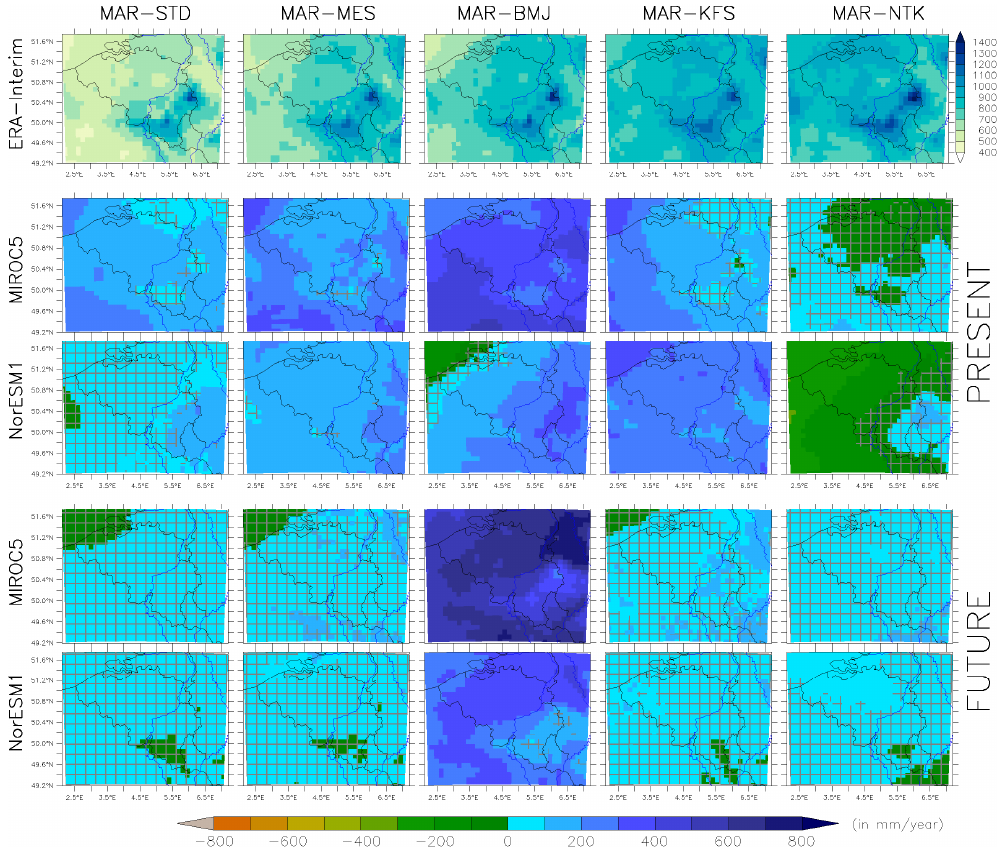
Figure 2. (Top) ERA-Interim: Mean annual precipitation (in mm/year) over 1987–2017 simulated by Modèle Atmosphérique Régional (MAR) forced by ERA-Interim for the five convective schemes. (Middle) PRESENT: Anomalies (in mm/year) between the mean annual precipitation over 1987–2017 simulated by MAR forced by MIROC5 and NorESM1-M compared to MAR-ERA for the five convective schemes. (Bottom) FUTURE: Future changes (in mm/year) between the mean annual precipitation over 2070–2100 simulated by MAR forced by MIROC5 and by NorESM1-M compared to MAR forced by MIROC5 and by NorESM1-M over 1987–2017 for the five convective schemes. Cross-hatched pixels indicate that anomalies are statistically insignificant with respect to the interannual variability of the reference field. MAR-STD represents the results of MAR using the standard version of the convective scheme (based on the former version of the MESO-NH model); MAR-MES uses a new version of the convective scheme from the MESO-NH model; MAR-BMJ uses the Betts–Miller–Janji ć convective scheme; MAR-KFS uses the Kain–Fritsch convective scheme while MAR-NTK uses the modified Tiedtke convective scheme.